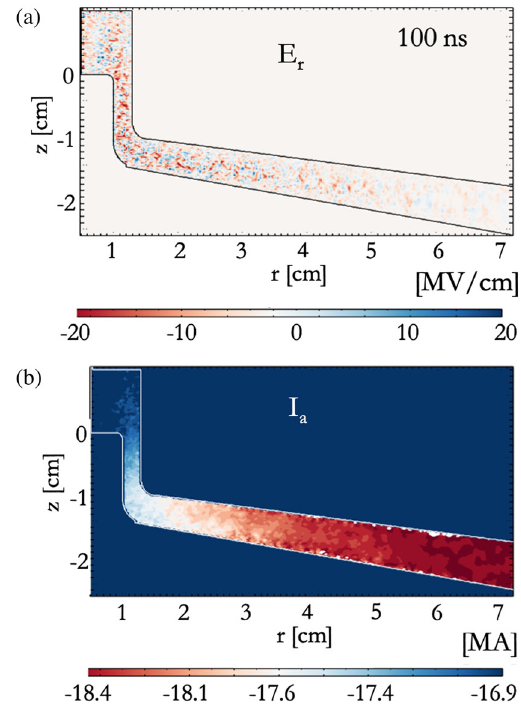
points.FIG. 15. Contour maps of (a) E r and (b) the anode current at 100 ns for the simulation in Fig.